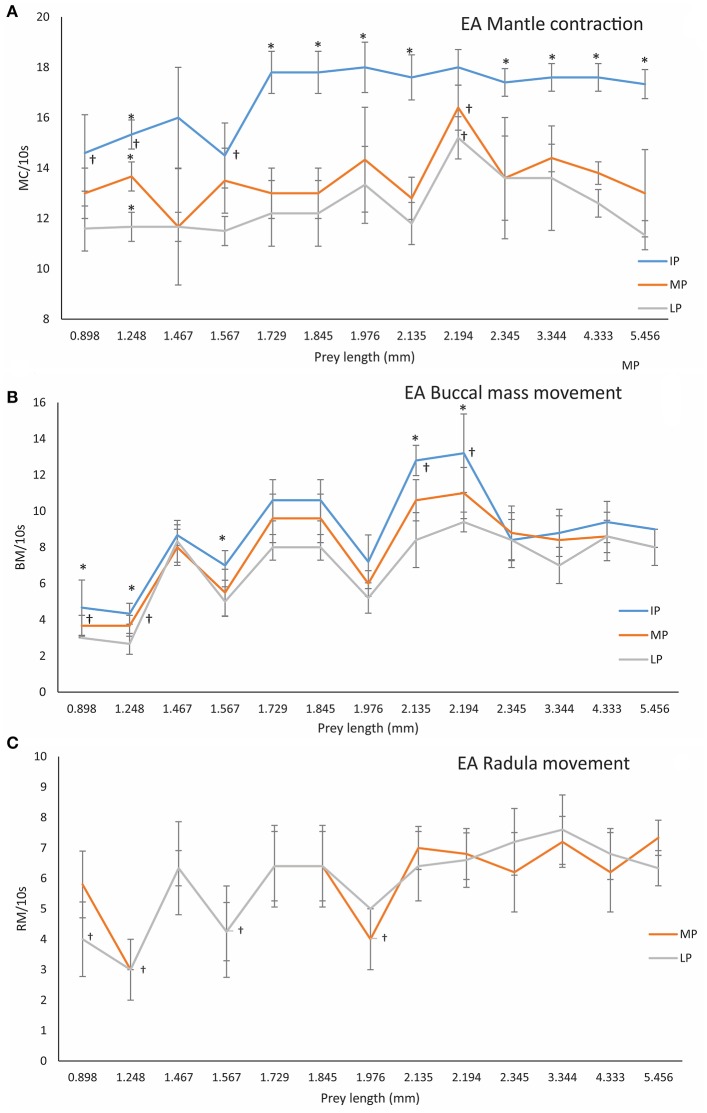
Frequency of MC (Mantle contractions, A), BC (Buccal mass movements, B) and RM (Radula movements, C), in different PPC (predator-prey combination phases), i.e., IP (initial phase), MP (middle phase), and LP (late phase) of EA (effective attacks) by 3 dph O. vulgaris paralarvae in relation to prey length. Data are plotted as mean ± SD. Symbols (†) indicate significant differences between prey-lengths in the same phase (one-way ANOVA, p < 0.05). The asterisk (*) indicates significant differences within prey-type between PPC phases (ANOVA-RM, p < 0.05; see Section Materials and Methods for details).